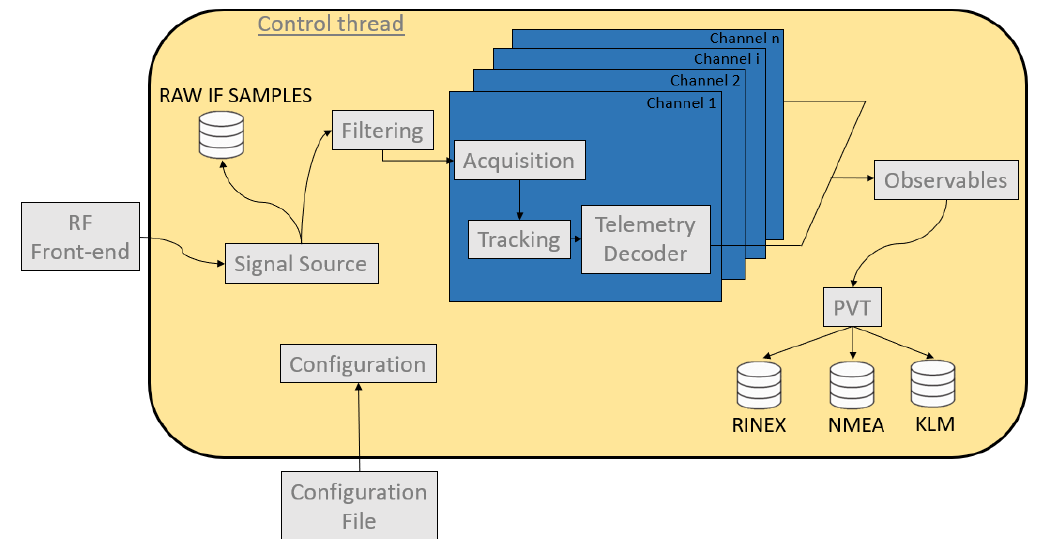
Figure 2. Global Navigation Satellite Systems Software-Defined Receiver (GNSS-SDR) flowgraph. Figure adapted from